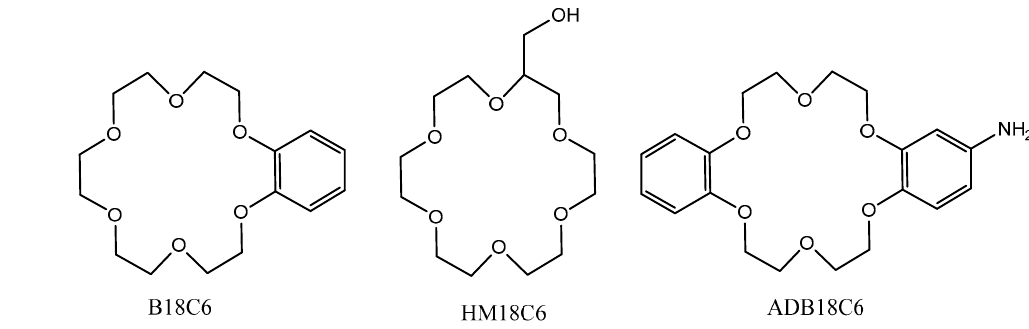
Figure 1. Structures of the used CEs.